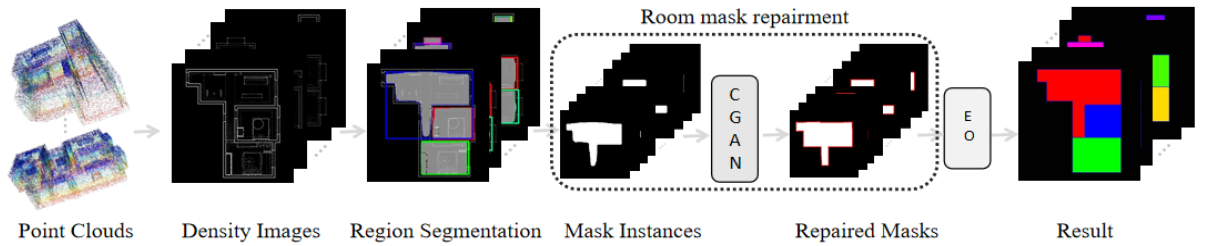
Figure 1. Framework of the proposed method, where CGAN is a GAN-based network and EO is the edge optimization algorithm.